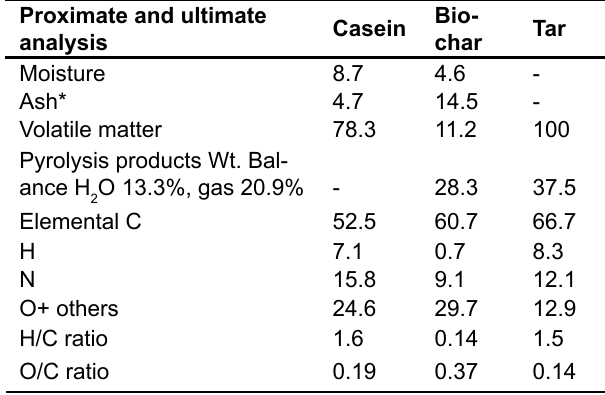
Table1. Analysis of casein, biochar and tar,